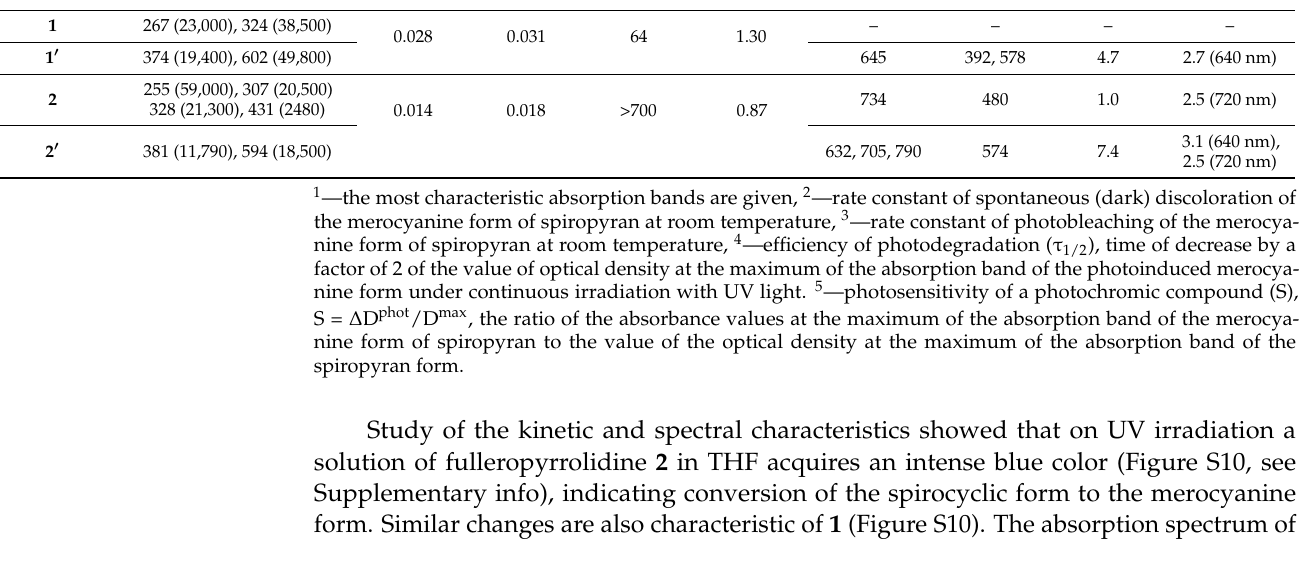
Table 1. Spectral–kinetic characteristics of compounds in spiropyran ( 1 , 2 ) and merocyanine ( 1 ′ , 2 ′ ) forms.